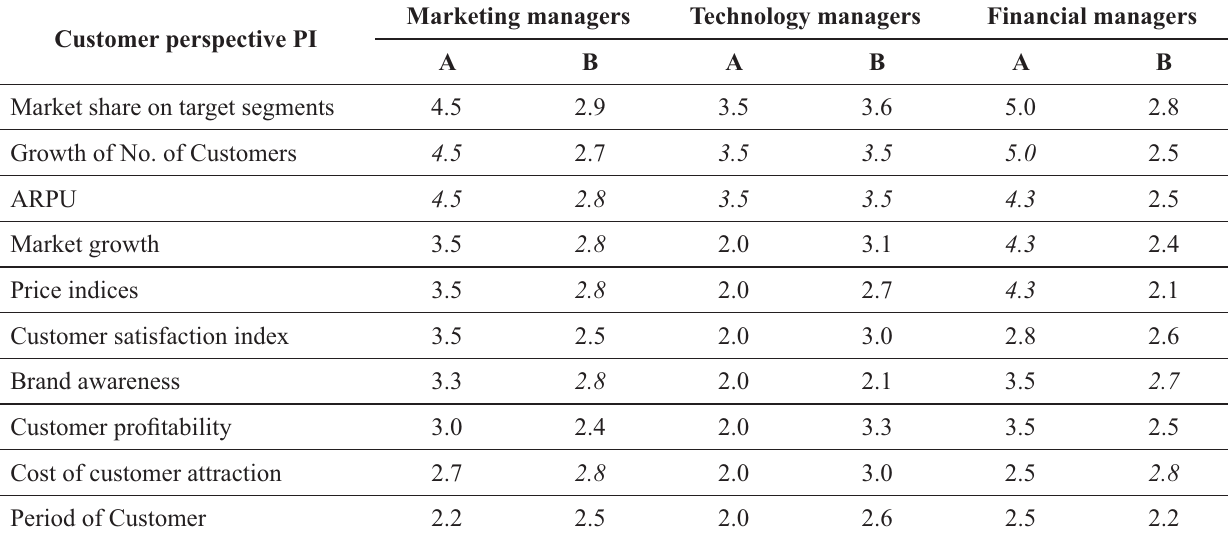
Table 3. Customer perspective PI usage by managers of companies A and B (mean)